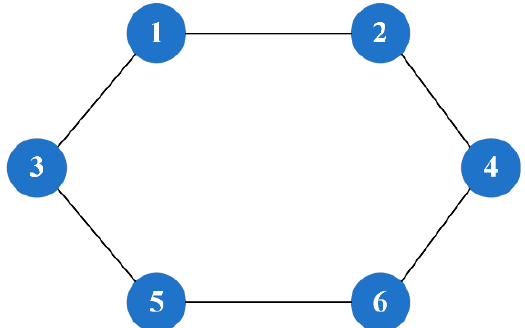
Figure 3. An example of six distributed generator (DG) units connected based on ring communication topology.